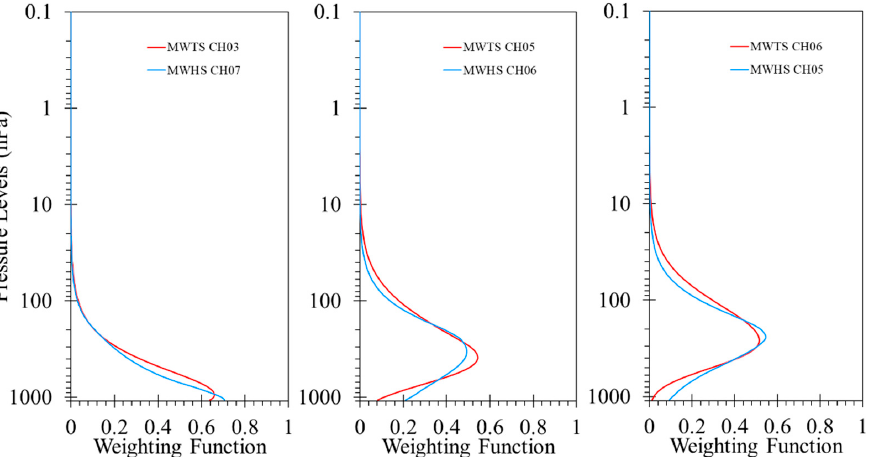
Figure 1. The distribution of the weight functions of the dual oxygen pairing channels in the low ( left ), middle ( middle ), and high ( right ) troposphere. The red and blue curves represent the MWTS and MWHS channels, respectively. Table 2. Channel characteristics of paired channels.